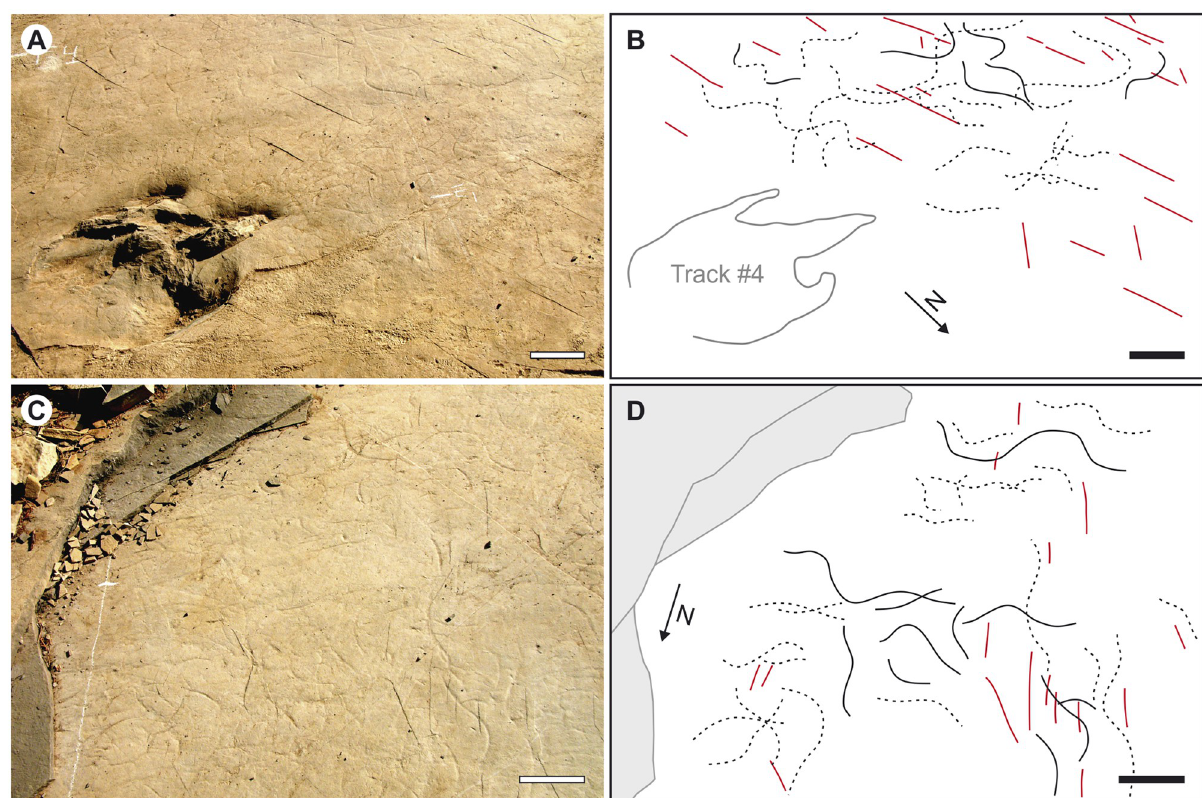
Fig 5. Undichna fish trails in Magenta LH-Mg-10-16. (A) and (B). Fish trails associated to the theropod footprints. (C) and (D). Accumulation of fish trails. Lines in black trails, and in red, wrinkles marks. Scale, 10 cm.